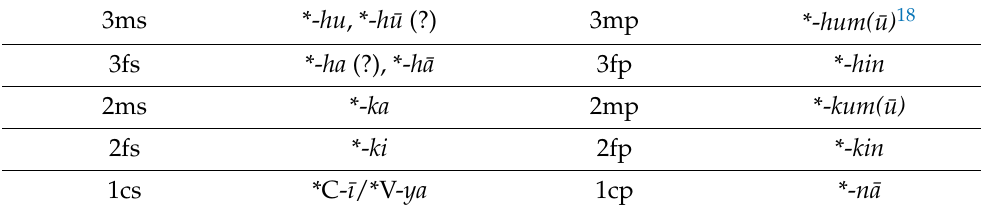
Table 9. Reconstructed Proto-Arabic Pronominal